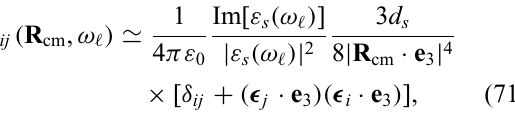
= ω and oscilla- 0 k = (cid:2) , yields the ground-state heating rate 0 k ) h ( R )/ m ω [71,105]. For k T / (cid:2) ω 0 0 eq 0 0 B